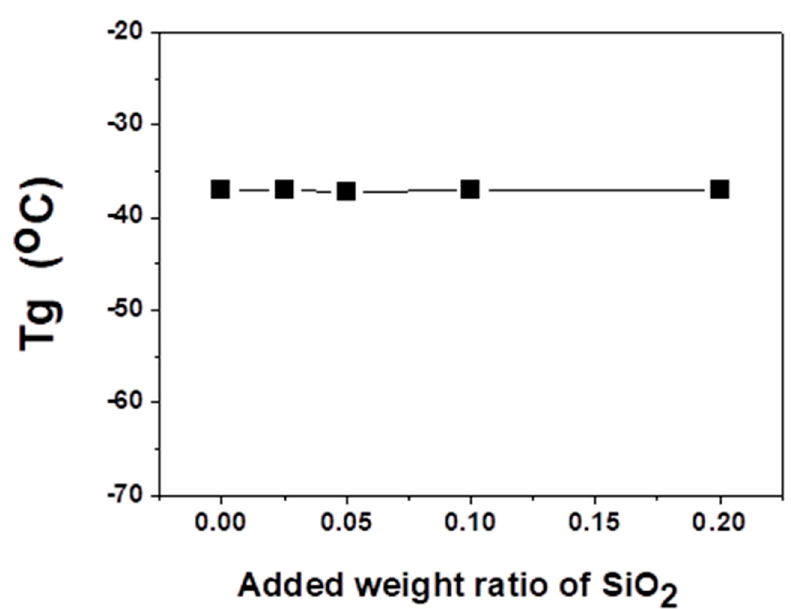
Figure 6. The glass transition temperature (T g ) of 1/1/0.85 EPR/Ag metal/ p -benzoquinone composites with varying contents of silica nanoparticles.